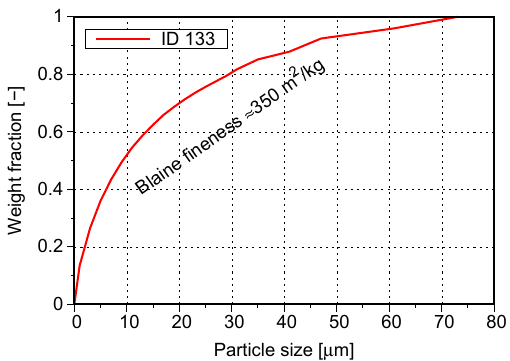
Figure 1. Discretized particle size distribution of cement ID 133.